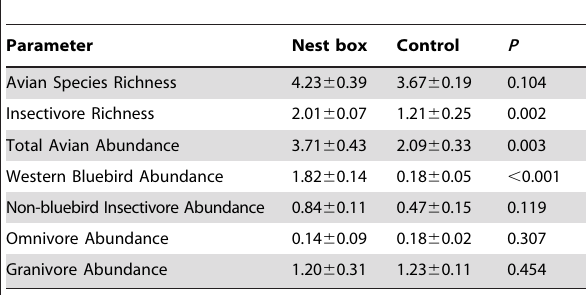
Table 2. Mean ( 6 SE) avian species richness observed or heard over the 30-minute observations and average avian abundance per 5-minute observation interval for nest box treatments and control